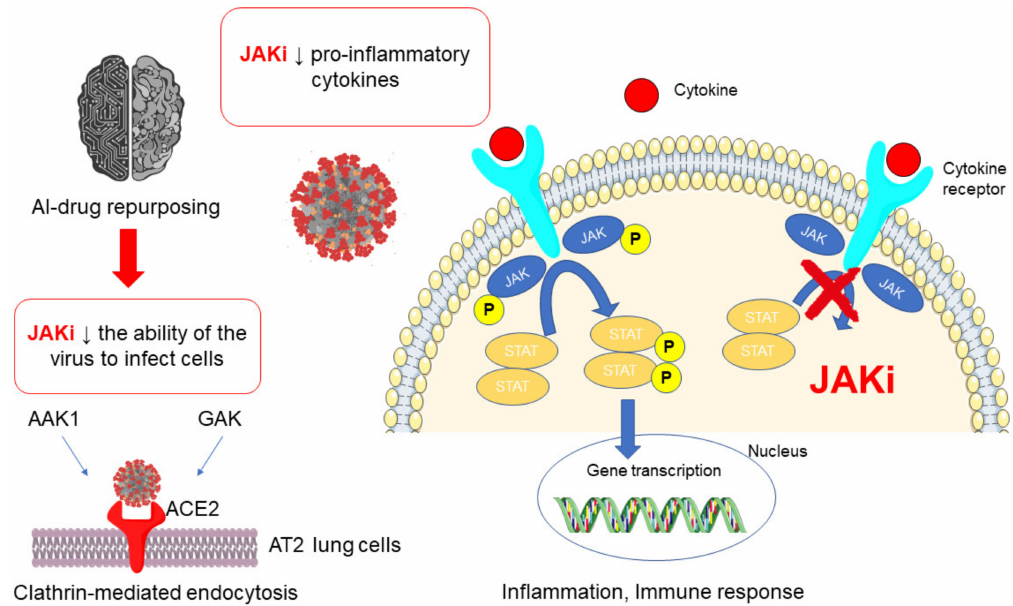
Figure 1. JAK inhibitors (referred as JAKi) in SARS-Cov-2 treatment: rationale and mechanisms of action. AI: artificial